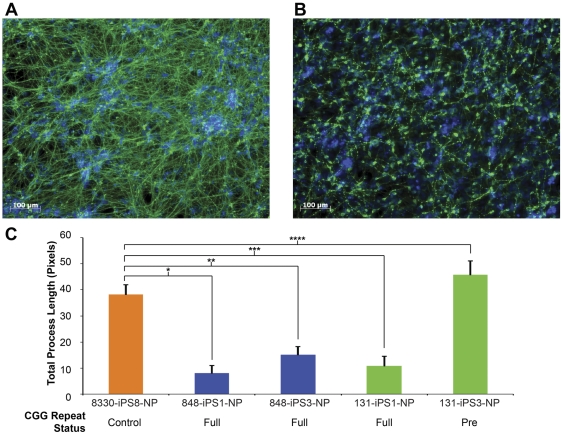
Aberrant Neural Differentiation of FXS iPSC-derived Neuronal Progenitors.Immunocytochemical analysis of Tuj1 expression (green) in neuronal progenitor cells differentiated upon mitogen removal of (A) FMRP+ control line 8330-8 and (B) FMRP- FXS line 848-3, overlaid with nuclei DNA staining (blue) (see Figure S1 for additional images). (C) Quantification of neurite process length in indicated iPSC-NP lines. Two wells (6-well plate) were imaged, 9 images per well (n = 18 images per sample). P-values as indicated *1.5e-13, **1.1e-10, ***3.1e-13, ****1.4e-4.